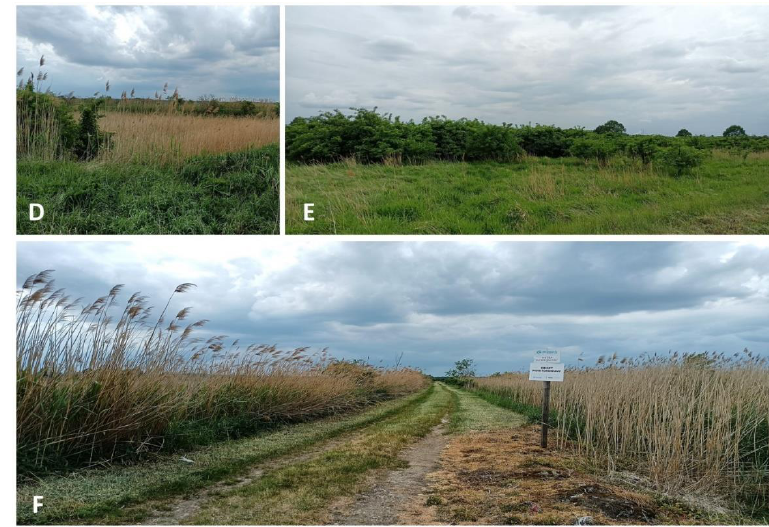
Figure 1. Irrigation fields Wrocław, Poland, present condition. ( A ) Plant communities with Carex Buekii Wimm , ( B , C ) remains of the hydrotechnical infrastructure ( D , F ) reed rush, and ( E ) willow bushes (photos: A. Krzemińska and A.